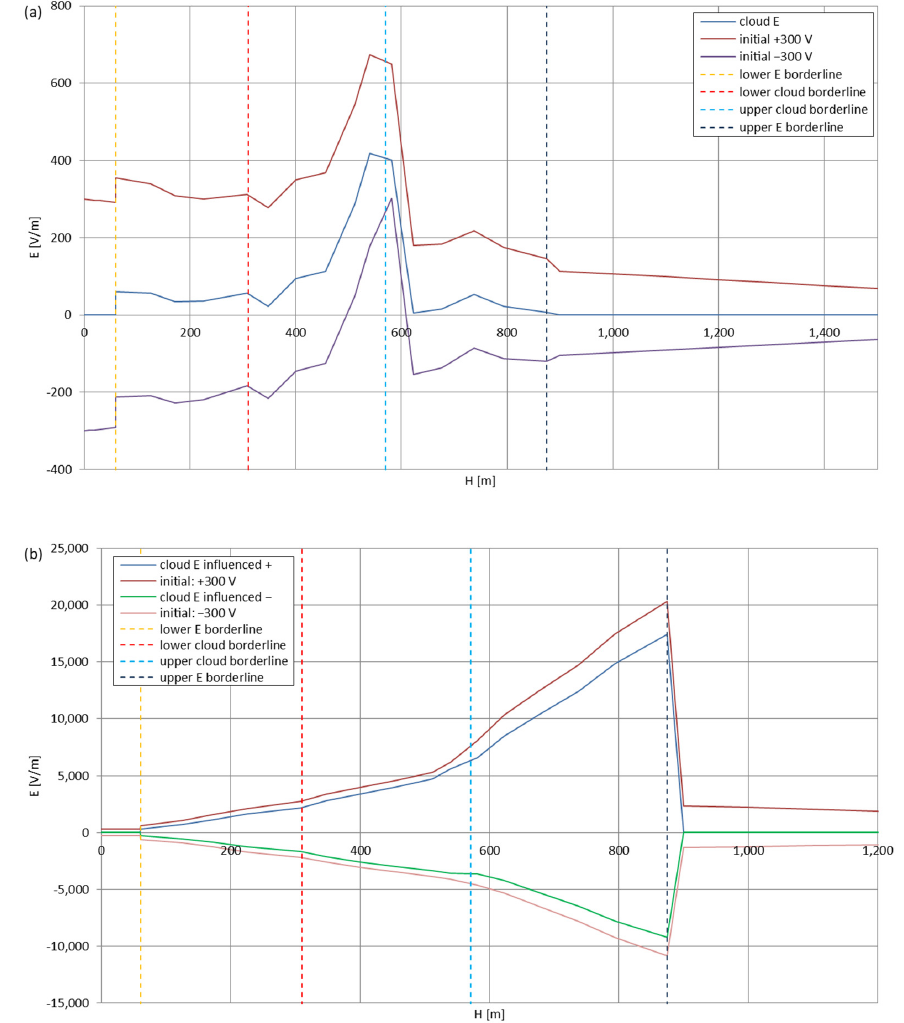
Figure 8. Maximum electric field strengths around the wire antenna passing through Stratocumulus cloud charged negatively: ( a ) ‘static’ case and ( b ) ‘dynamic’ case.